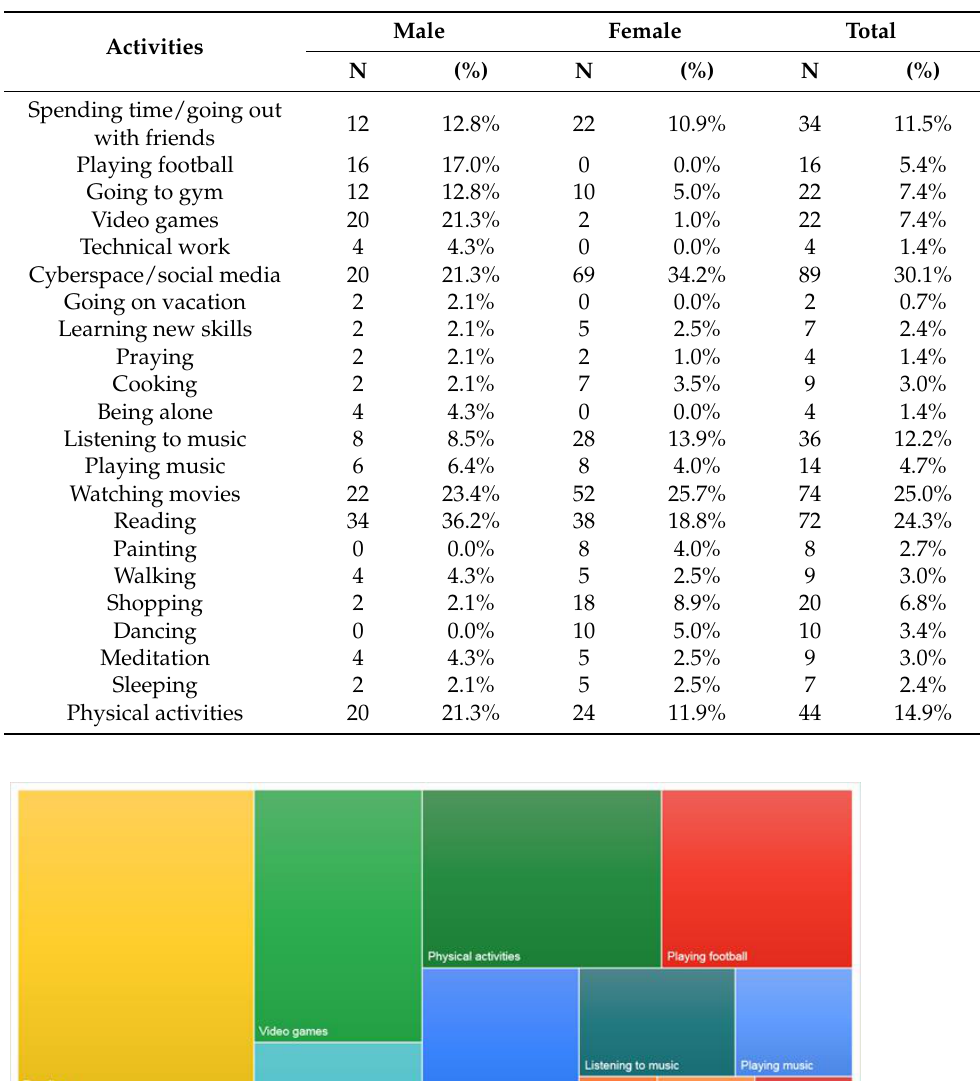
Table 5. Self-care activities suitable for their age and gender (question number 3).